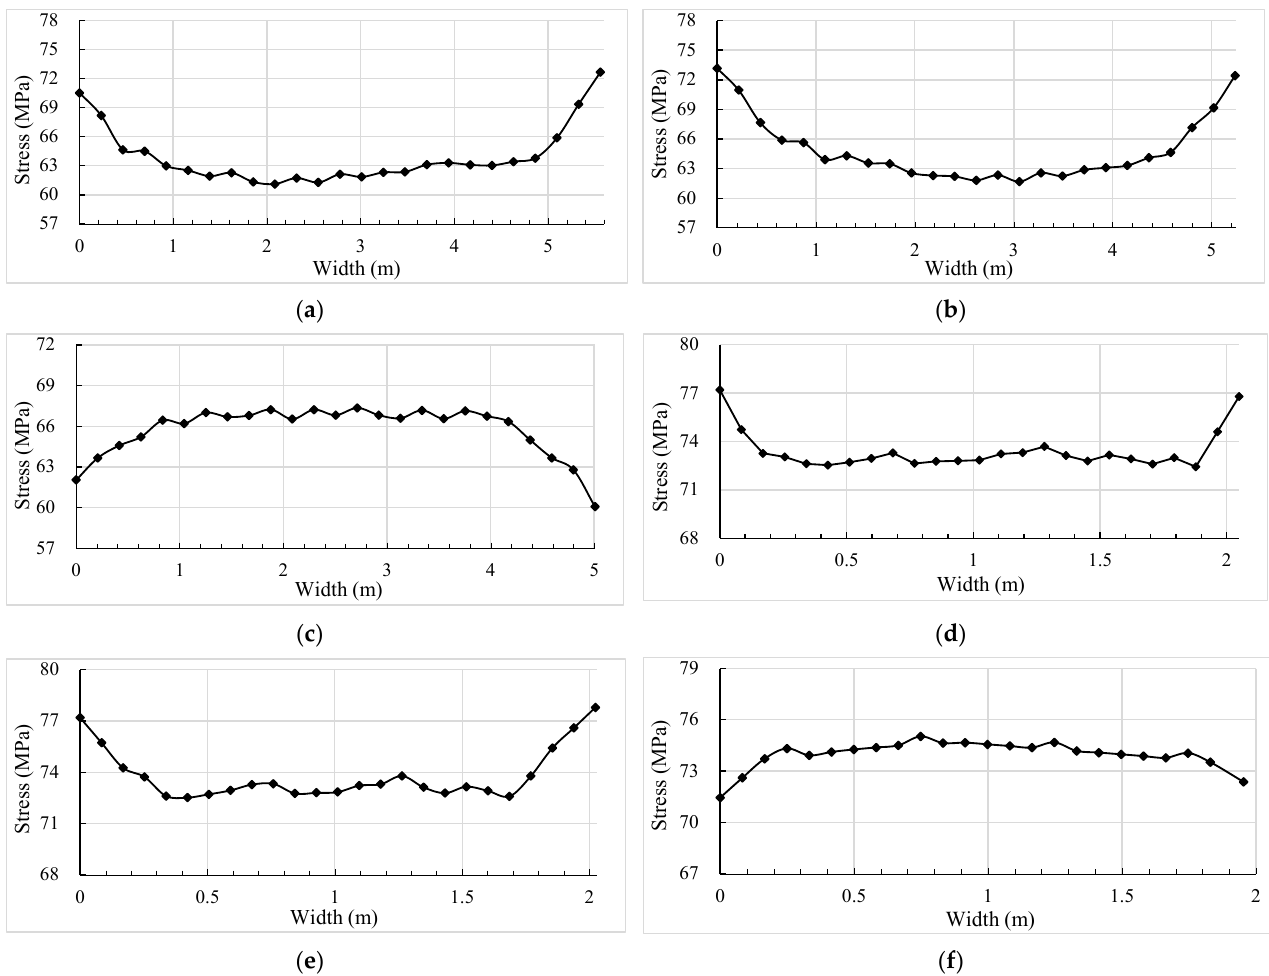
Figure 16. Stress distribution in the top slab of the main arch rib: ( a ) Section A-A; ( b ) Section B-B; ( c ) Section C-C; ( d ) Section D-D; ( e ) Section E-E; ( f ) Section F-F.